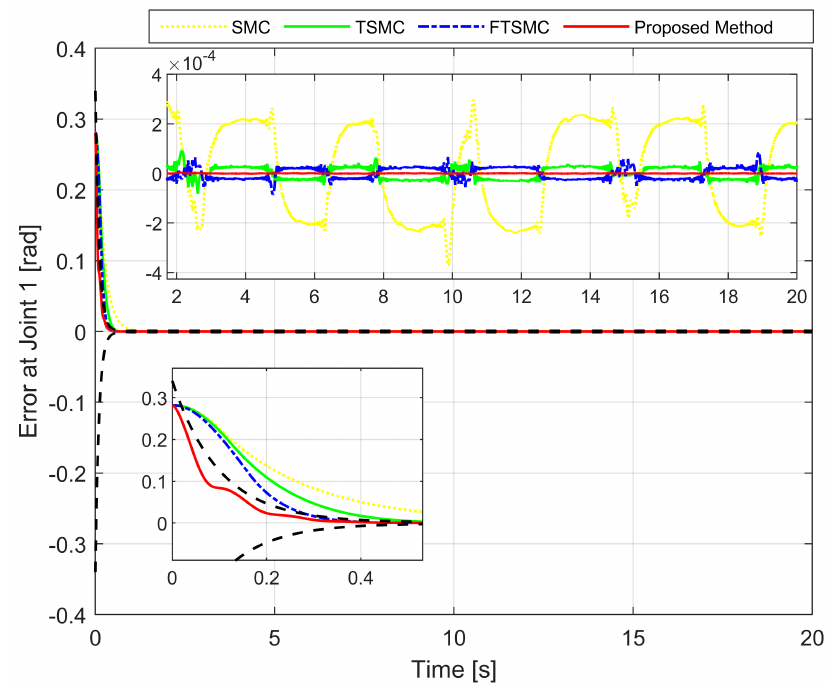
Figure 3. The first joint error comparison between the real trajectory of the robot and the reference trajectory.